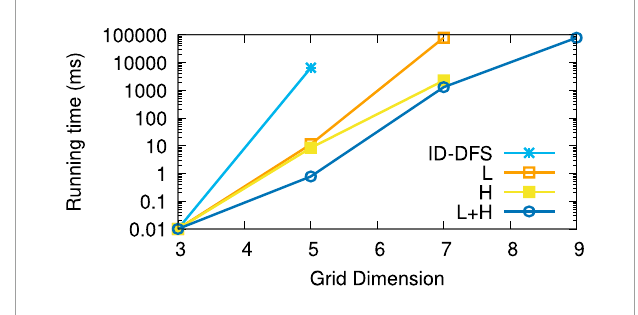
FIGURE 10 Average running times (in ms) for the type (e) (labyrinth) grids.